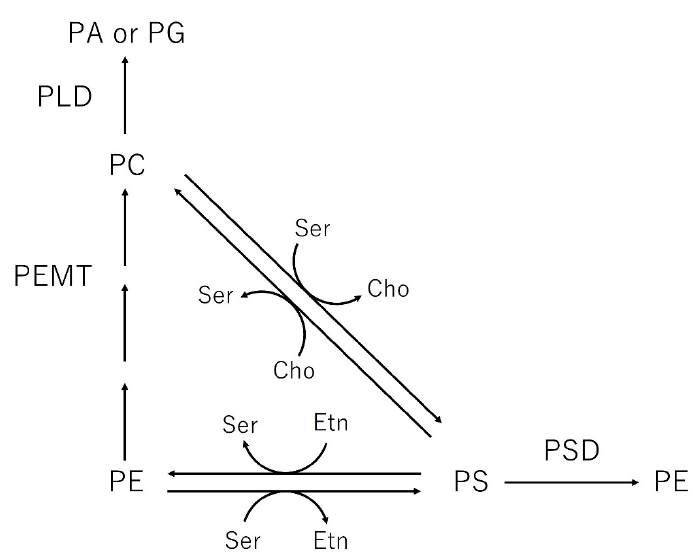
Figure 3. Alternative pathways for phospholipid synthesis in the brain (PA is phosphatidic acid). Ser: serine, Cho: choline, Etn: ethanolamine. Modified from [60] with permission from Elsevier.